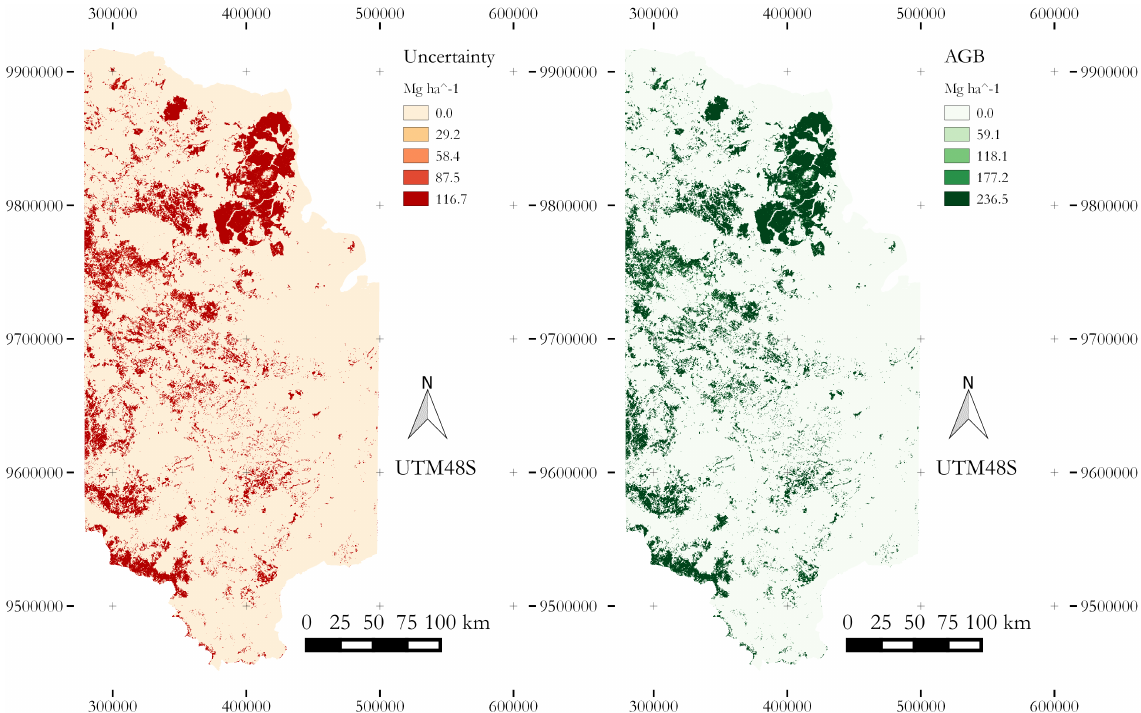
Figure 5. Left image: uncertainty of the 2007 AGB for our 10.7Mha study area. We created the uncertainty map by applying the 24.7% total uncertainty across the landscape. Hence those areas which have higher estimates of AGB have the highest absolute uncertainties associated with them. The uncertainties appear to be fairly constant across the landscape because we are considering only the high-biomass forests in the analysis. Right image: the AGB map for 2007. The AGB legend is scaled continuously between minimum and maximum values. The largest remaining block of forest in the north-east of the image is Berbak National Park, as well as the forests of ZSL’s pilot REDD + project, the Berbak Carbon Initiative. The AGB map is available online in a repository at http://datadryad.org/resource/doi:10.5061/dryad.4cc5m.